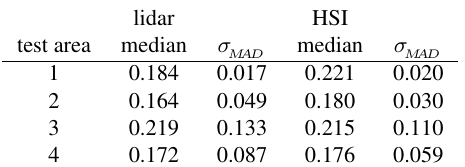
Table 1: Reflectance distributions for the four test areas, evaluated for a minimum echo ratio of 75% each. Detailed results w.r.t. varying minimum echo ratio for test area 4 are given in Table 2.